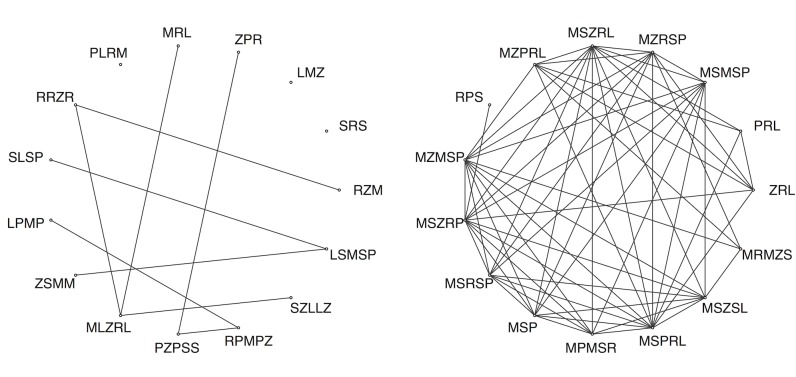
Generations 0 (left) and 10 (right) of chain 8.These network diagrams link strings that share at least one bigram sequence. Although the string sets start out containing relatively few edges (links), by the end of the chain the strings have become quite densely connected to one another.